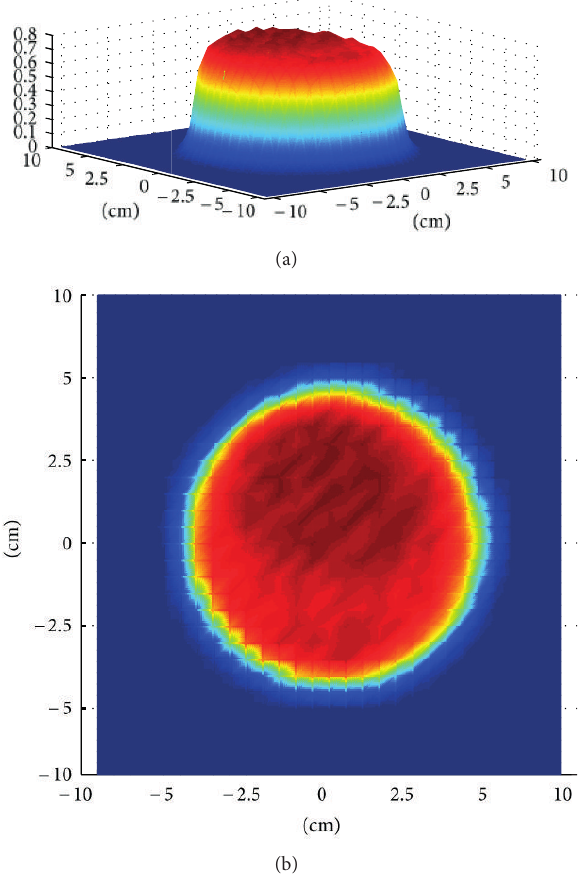
Figure 8: Measurement of the S1 - S2 beam: 3D and 2D plots.